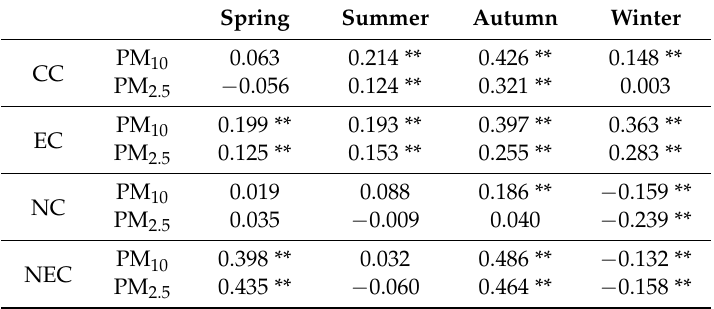
Table 2. The seasonal variation of correlation coefficients in different regions from 2013 to 2017.